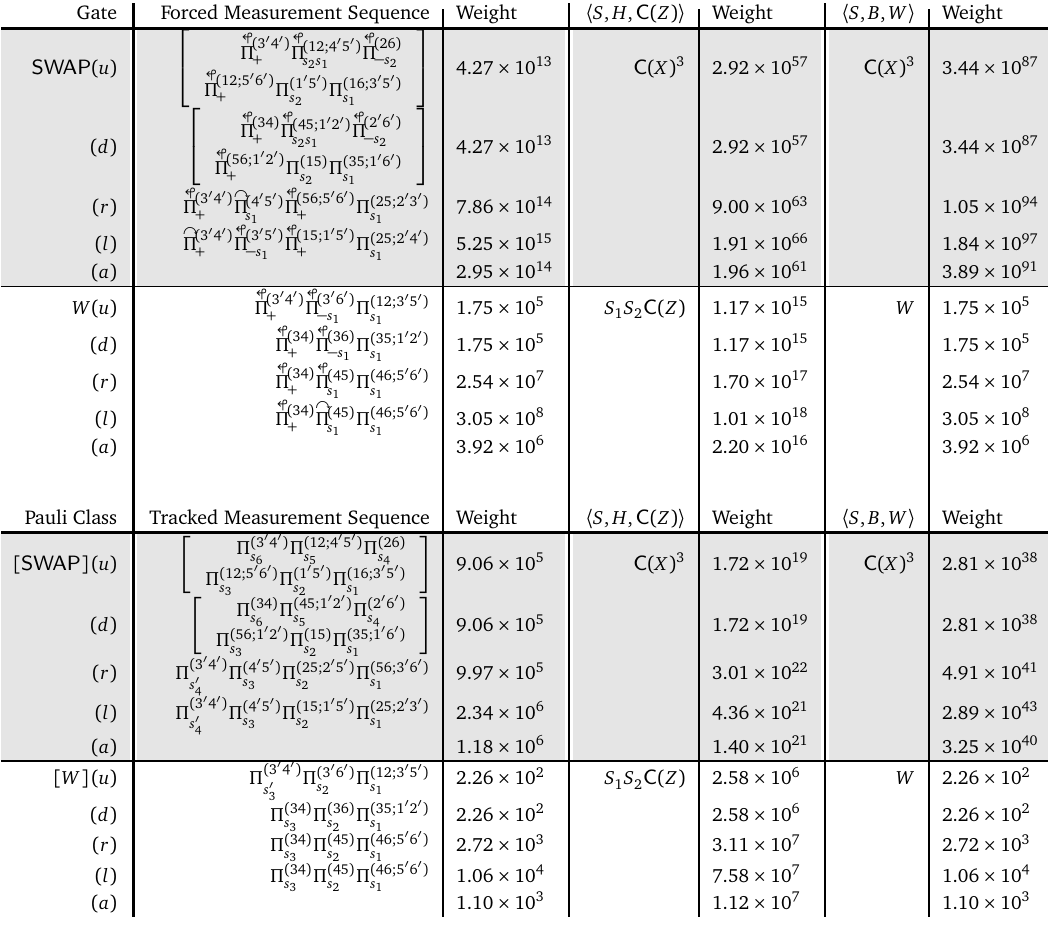
Table 19: Minimal difficulty weight measurement sequences for the two-qubit SWAP and W gates when using forced-measurement methods and the Pauli cosets of SWAP and W when using Majorana-Pauli tracking methods. For compari- son, we also present the corresponding realization of the gates formed by using SWAP = C ( X ) C ( X ) C ( X ) with C ( X ) as given in Tables 16 and 12 21 12 12